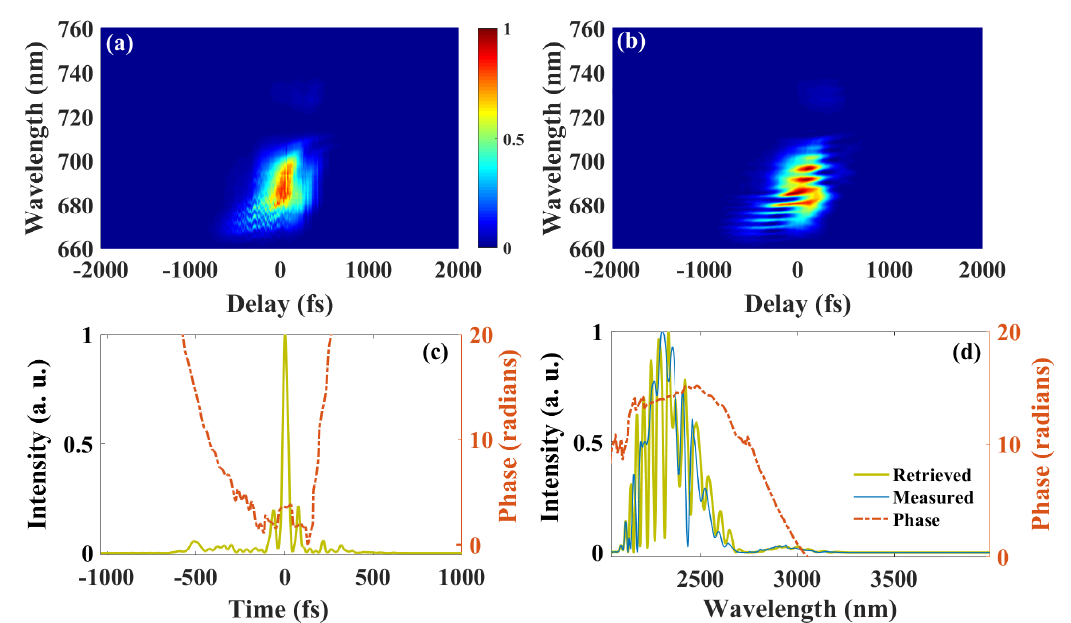
Figure 5. ( a ) Measured trace, ( b ) retrieved trace, ( c ) retrieved temporal profile, and ( d ) retrieved spectrum from the SFG-XFROG for SC pulses generated by the output of the regenerative amplifier after 45 round trips. Best error value of